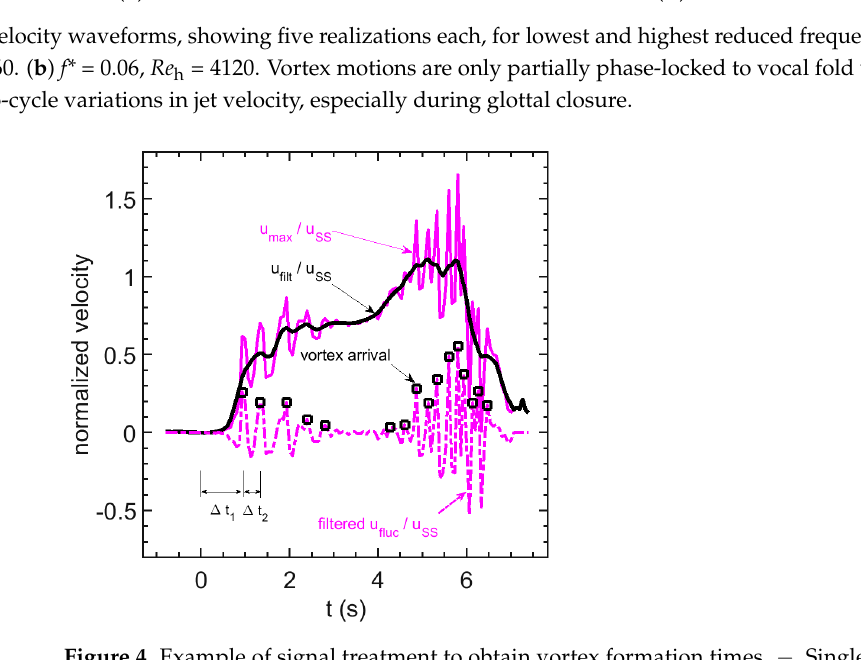
Figure 4. Example of signal treatment to obtain vortex formation times. −, Single realization of exit velocity waveform 𝑢 (cid:3041) for case Re h = 7160, f * = 0.04; −, low-pass filtered waveform, 𝑢(cid:3556) (cid:3041) , − ∙, velocity fluctuation u fluc Peaks of u fluc detected by peakdetB.m indicated by black squares. Vortex formation time estimates, ∆ t 1 and ∆ t 2 , for the first two vortices are also